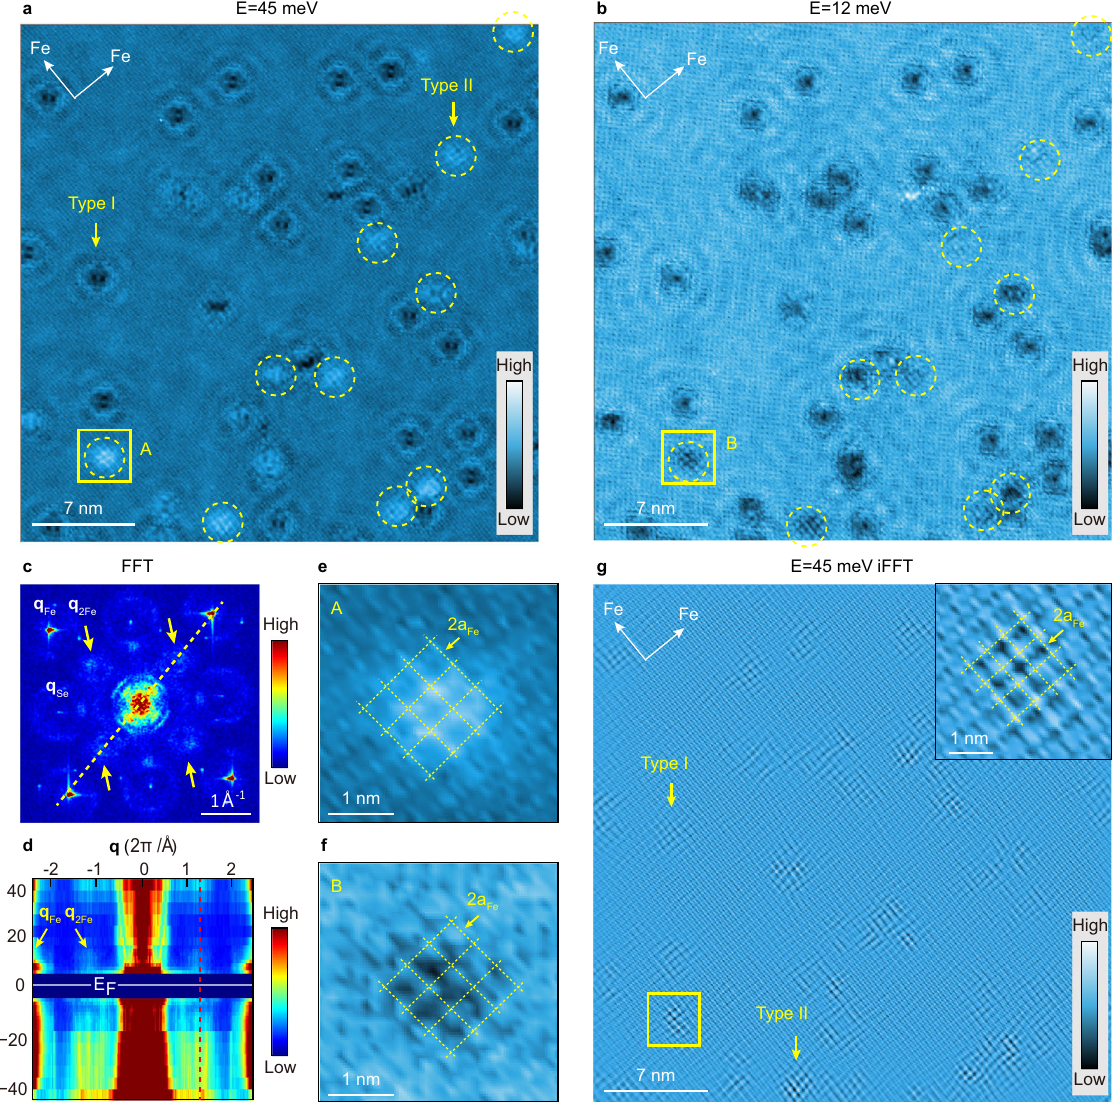
Fig. 2 | Spatial LDOS modulations in the Fe 1 − x Se region with x =0.54%. a , b Typical d I/ d V maps ( V b =45mV, I t =50 pA, Δ V =2mV). Type-II Fe-site defects are enclosed by the yellow dashed circles, while the others are the type-I defects. c FFTimageof thed I/ d V mapshownin( a ).AdditionalFFTfeaturesaround q 2Fe are marked by yellow arrows. d FFT line cuts extracted along the yellow dashed line in ( c ),takenatvariousenergiesandshowninfalsecolor.Thereddashedlineindicates